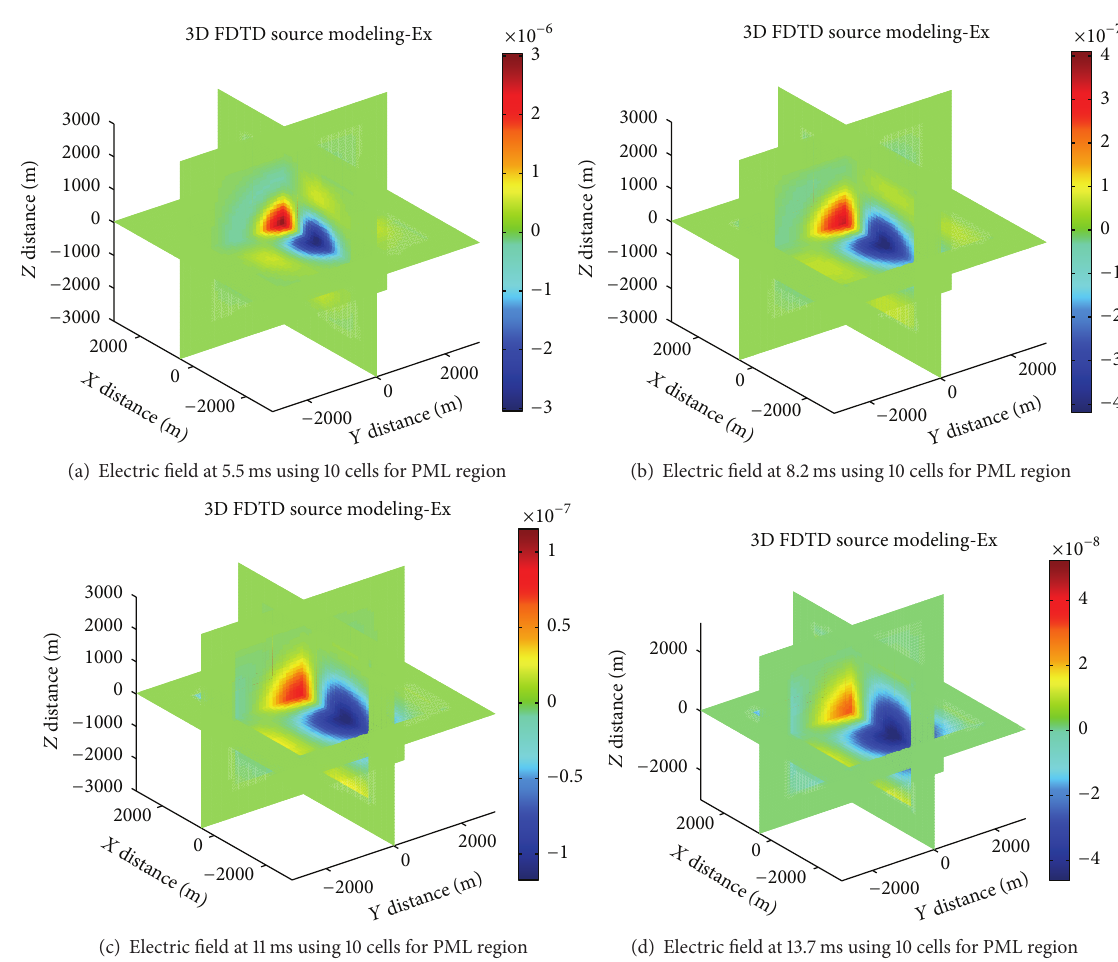
(b) Electric field at 8.2ms using 10 cells for PML region